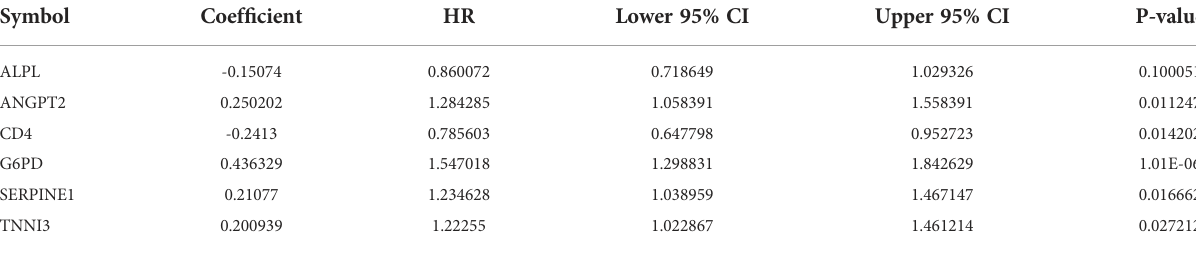
TABLE 2 Multivariate Cox proportional hazards regression